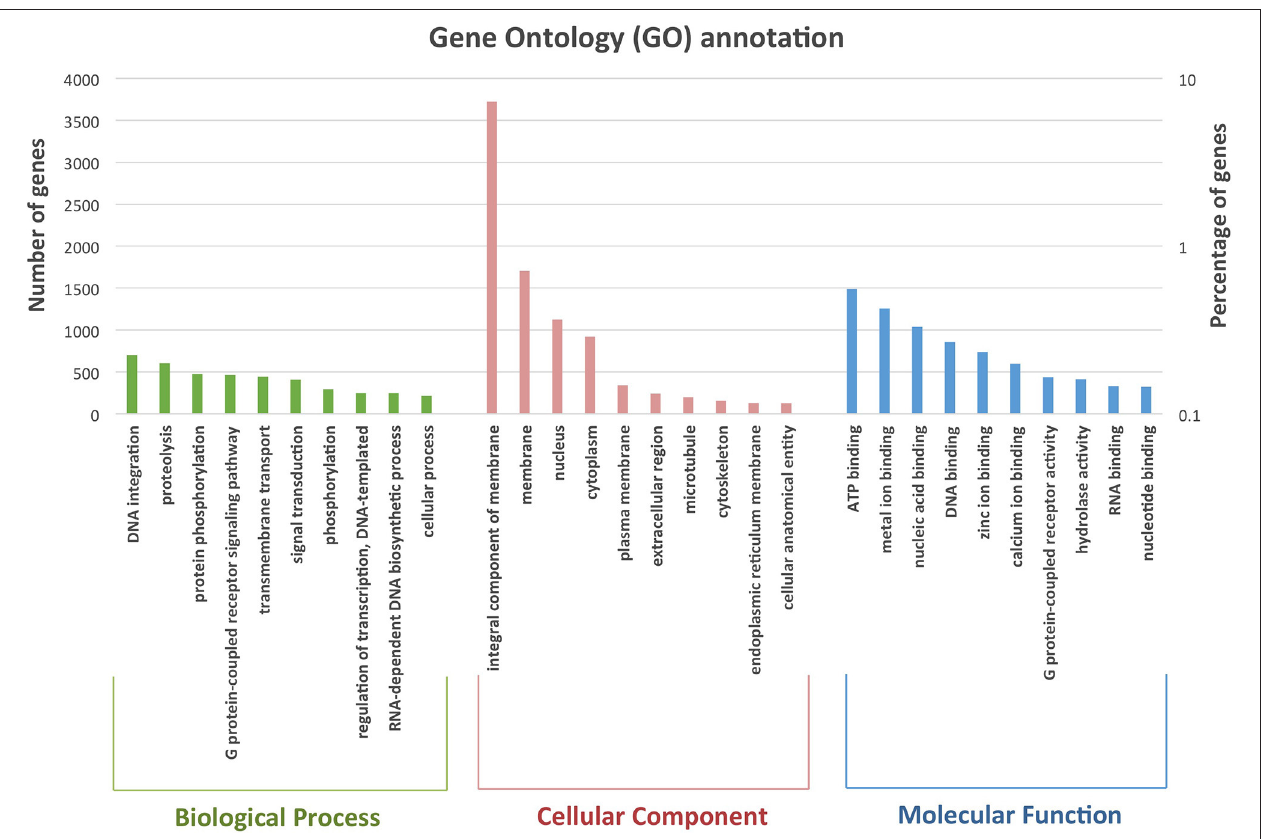
FIGURE 1 | Gene Ontology (GO) annotation of P. sinensis genes in the genome assembly. Results are summarized in three main categories: cellular components, molecular functions, and biological processes. A total of 23,240 genes have been assigned GO